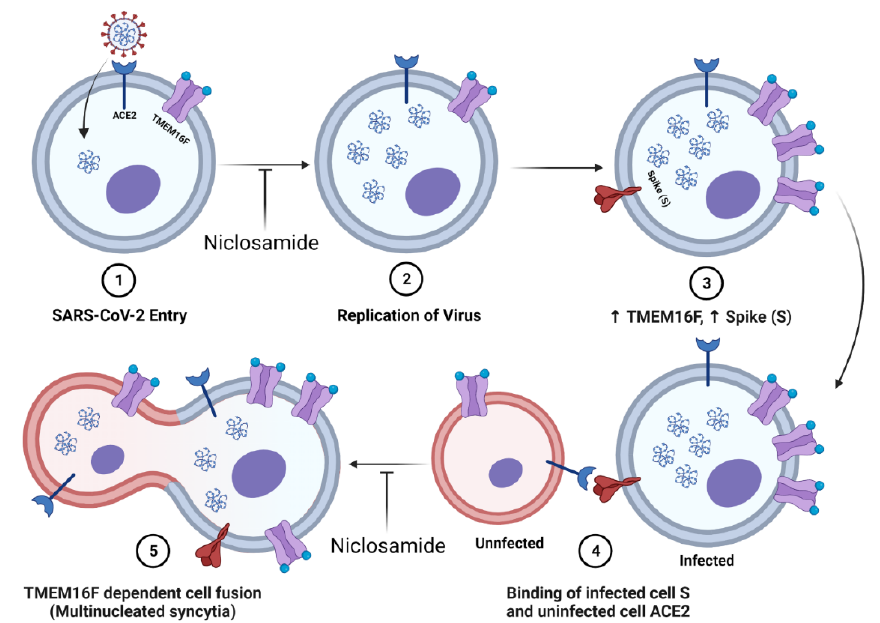
Figure 6. Diagram of niclosamide effect on SARS ‐ CoV ‐ 2 entry and spike protein ‐ mediated syncytia formation. ( 1 ) SARS-CoV-2 binds to the ACE2 receptor of the host cell and enters. Niclosamide has been shown to inhibit this entry step in vitro. ( 2 ) Viral replication generates many copies of the RNA genome. ( 3 ) Infection results in an increased expression of viral spike (S) protein and host cell TMEM16F at the plasma membrane. ( 4 ) The S protein at the surface of an infected cell binds to the ACE2 receptor of an adjacent uninfected cell. ( 5 ) Spike ‐ dependent syncytia formation is mediated by the calcium ‐ dependent lipid scramblase TMEM16F to generate multinucleated infected cell bodies. Niclosamide, an inhibitor of TMEM16F, has been shown to block spike ‐ dependent syncytia formation.